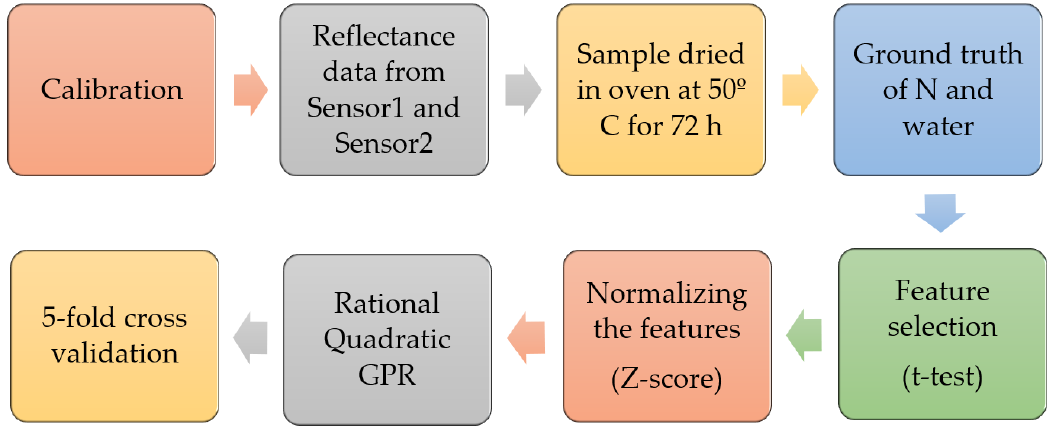
Figure 8. Process flow of the methodology.